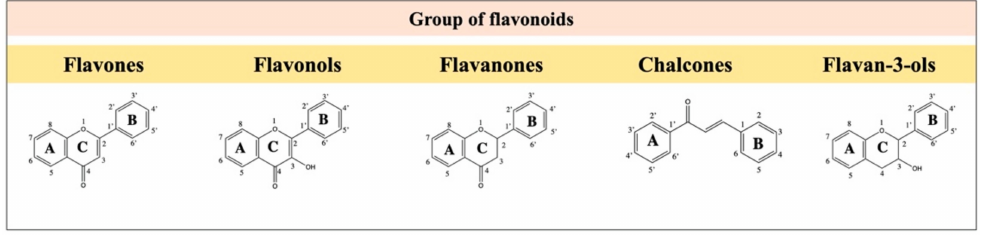
Figure 1. The chemical structures of the flavonoid groups discussed in this